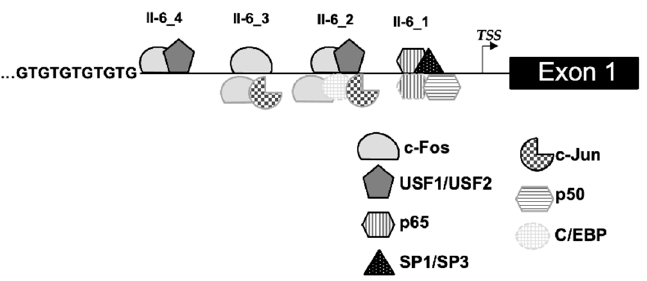
Figure 3. Schematic diagram of transcription factor binding to the Il-6 promoter region in nTregs (upper panel) compared to previously published findings (lower panel).